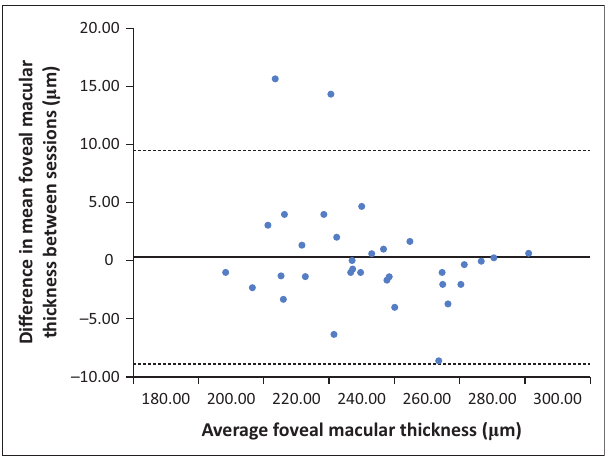
The solid line represents the mean difference and the dashed lines represent the upper and lower limits of agreement. FIGURE 3: Bland-Altman plot comparing iVue-100 foveal macular thickness measurements of the 50 right eyes taken by observer one in two separate sessions separated by a minimum of 1 day and a maximum of 70